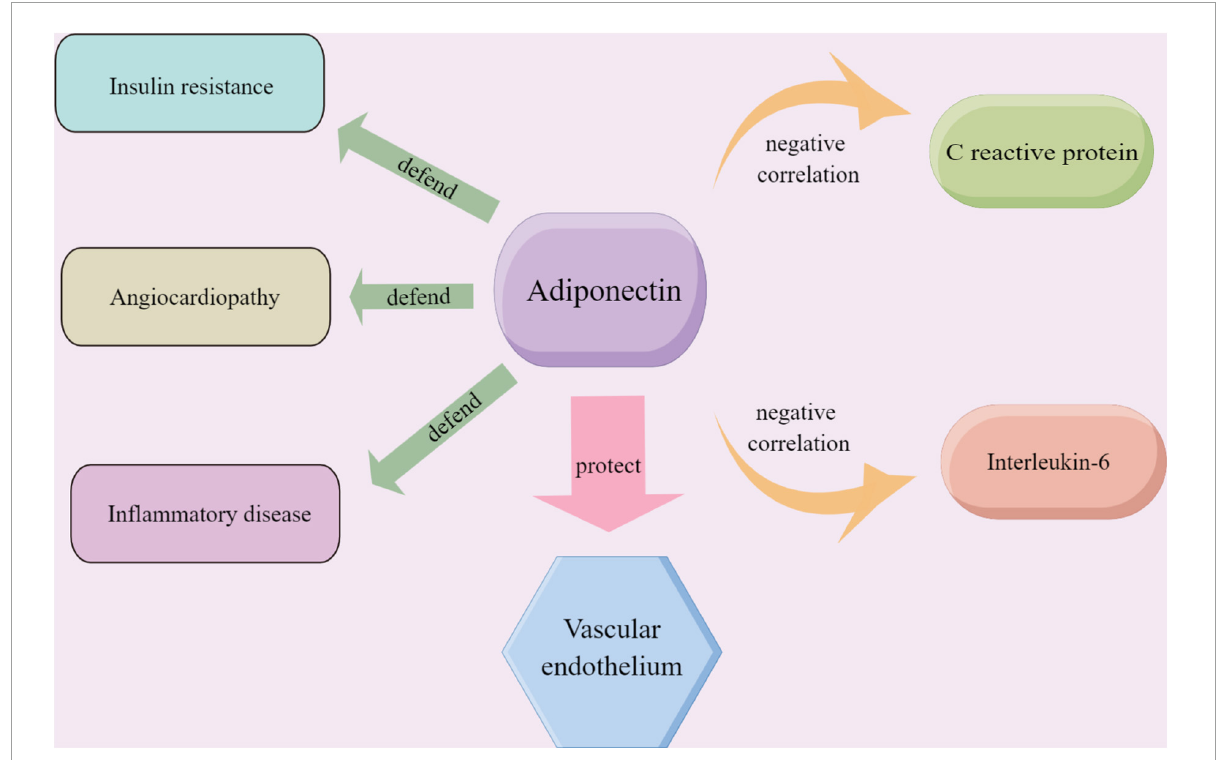
FIGURE6 The role played by adiponectin in endothelium-related vascular diseases and the relationship between adiponectin and the inflammatory markers including CRP and IL-6; the material in the picture was provided Friendly by Figdraw